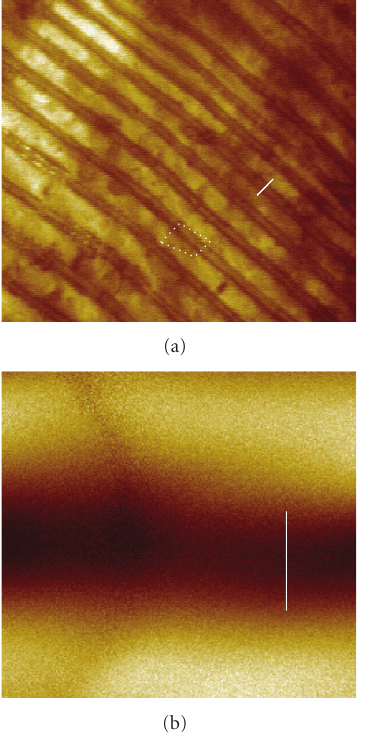
Figure 3: AFM topographic scans showing surface structure of the cuticle; (a) is a map from the scan on a larger area of about 3 × 10 5 square pixels (b) is a scan on a single pixel of about 2 . 5 × 10 6 nm 2 . Doted lines on (a) represents the region shown by (b). scale bars ∼ 0.5nm.